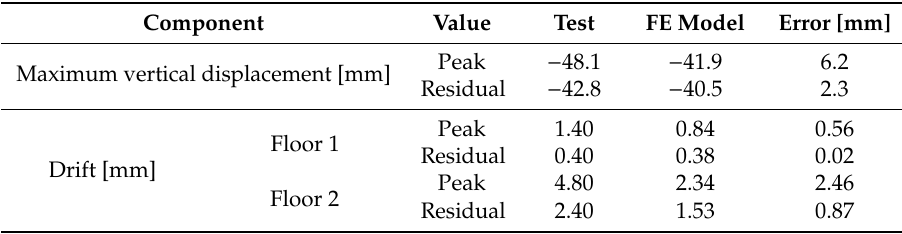
Table 2. Comparison of the peak and residual values of maximum vertical displacement and drift between the test [28] and the FE model.